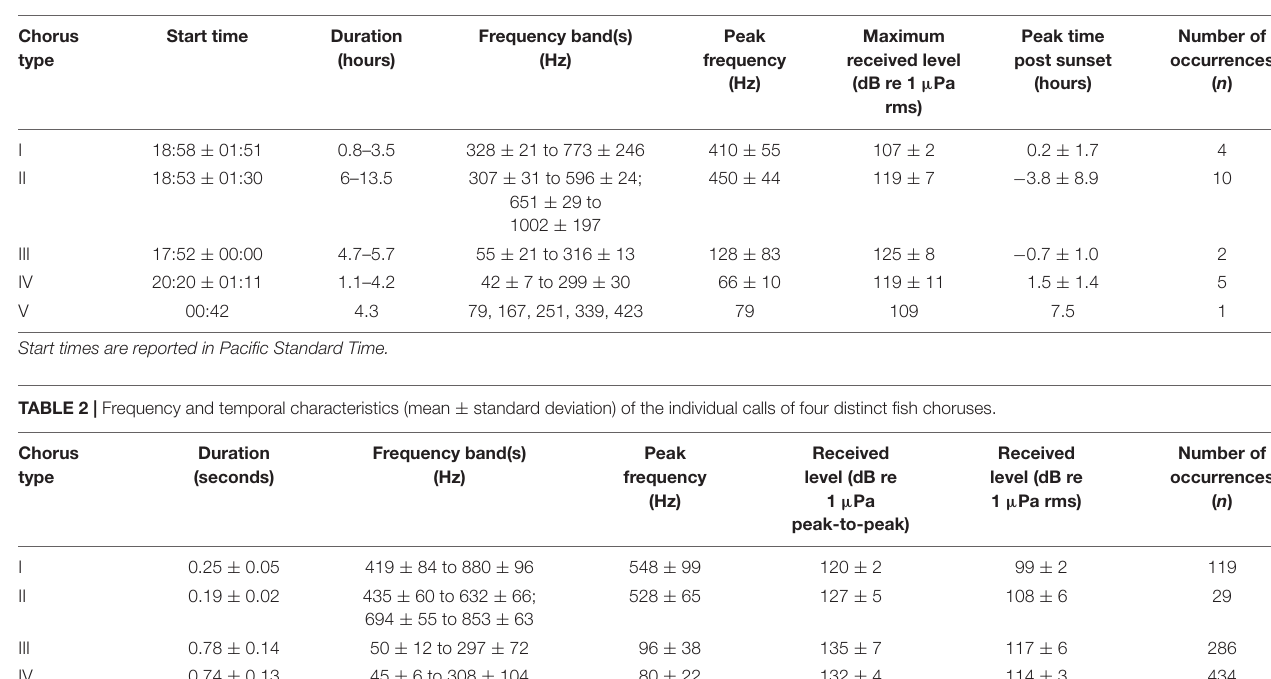
TABLE 1 | Frequency and temporal characteristics (mean ± standard deviation) of five distinct fish choruses.